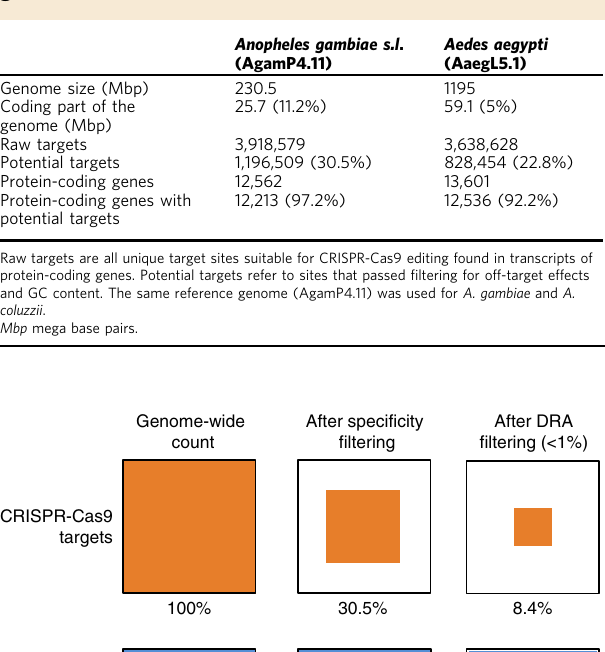
Table 1 Target sites for CRISPR-Cas9 editing in mosquito genomes.